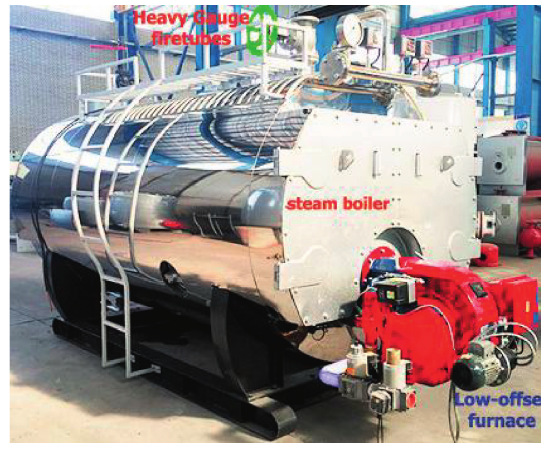
Figure 3: The industrial